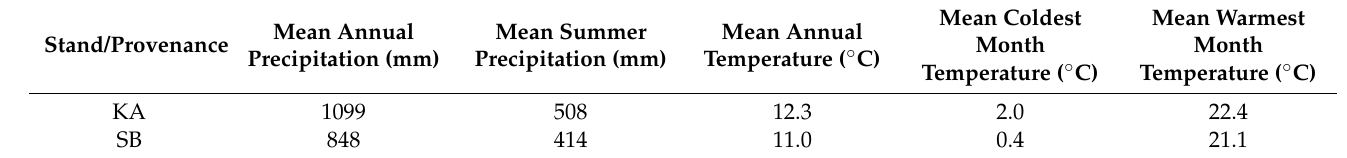
Table 1. Basic climate data for the sampled stands. Generated for the 1991–2020 period by ClimateEU software (https://sites.ualberta.ca/~ahamann/data/climateeu.html; (accessed on 23 June 2022)